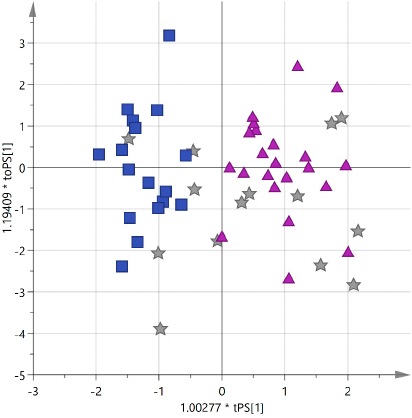
Figure 6. Predicted OPLS-DA score plot for blend EVOO samples from Salento with unknown percentages of Cellina/Ogliarola (blue squares = Cellina; purple triangles = Ogliarola, gray stars = blend predictions).